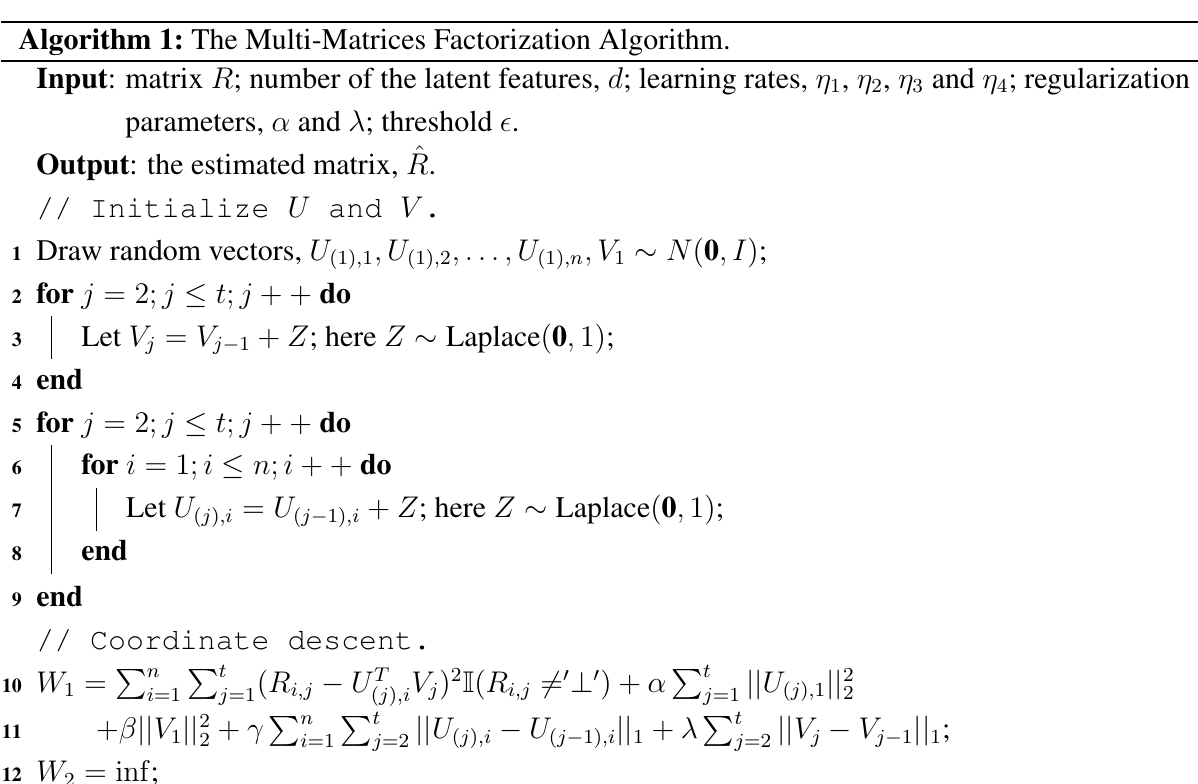
Algorithm 1: The Multi-Matrices Factorization